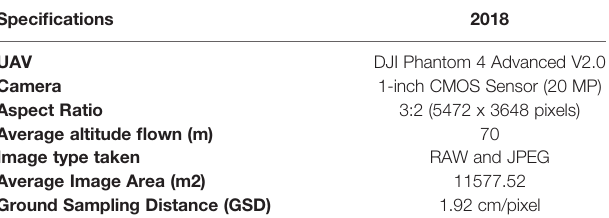
TABLE 1 | UAV and camera speci fi cations of